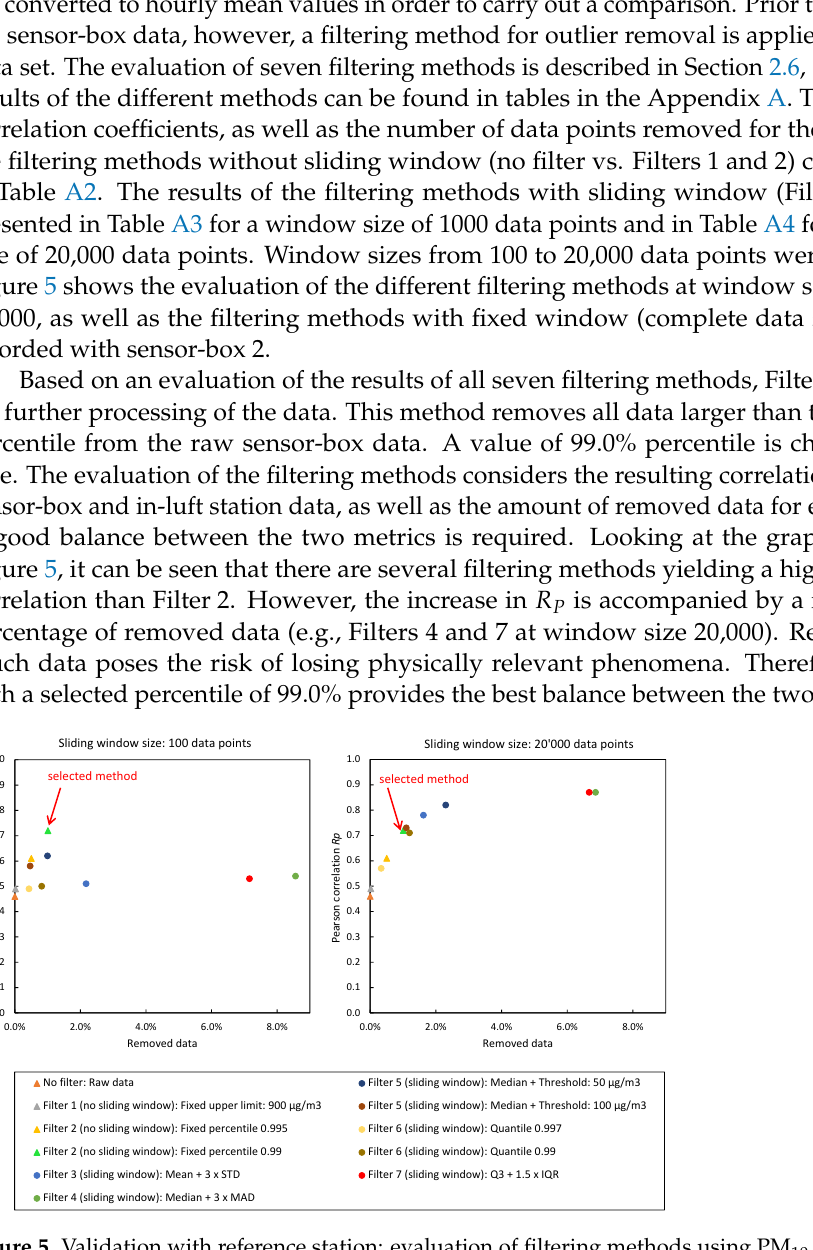
Figure 5. Validation with reference station: evaluation of filtering methods using PM 10 concentration measurements recorded with stationary sensor-box 2 between 17 November 2021 and 31 December 2021 in Stans, Nidwalden. Displayed is the Pearson correlation coefficient of in-luft and measurement data with different thresholds for the data